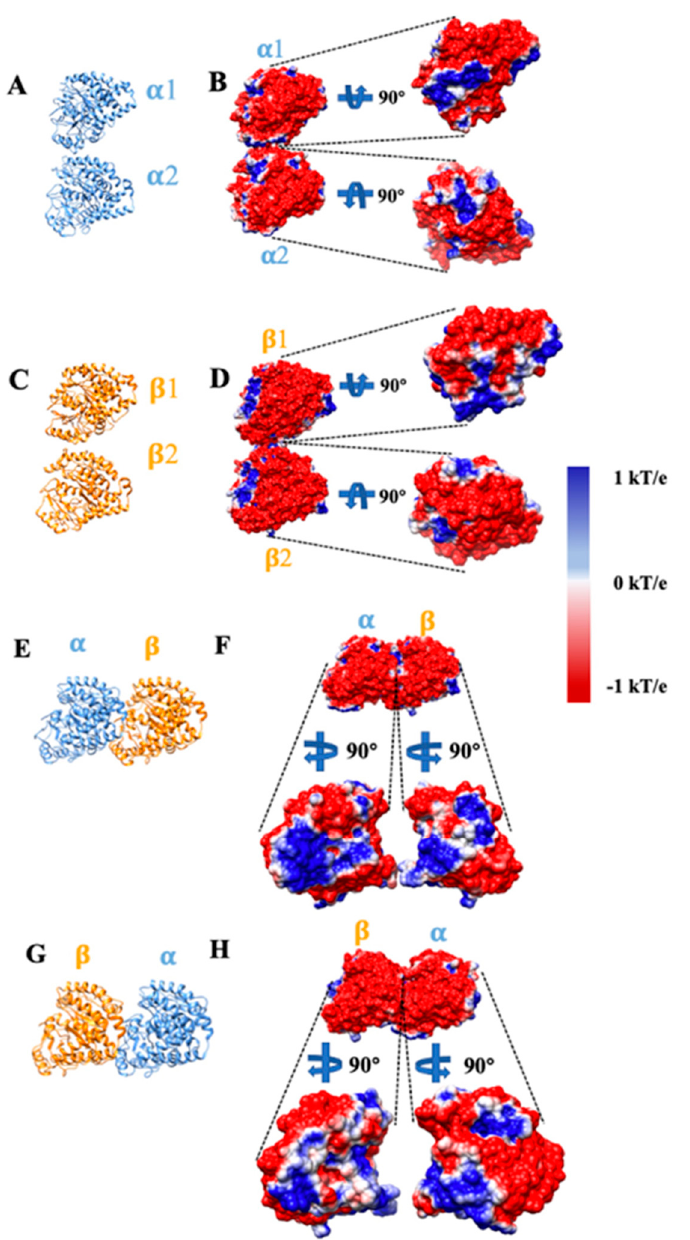
Figure 2. Electrostatic potential at the interfaces of tubulins ( α / α tubulin complex, β / β tubulin complex, α / β tubulin complex, and β / α tubulin complex). ( A , C , E , G ) The ribbon structures of α / α tubulin complex, β / β tubulin complex, α / β tubulin complex, and β / α tubulin complex. All α tubulins are represented in blue, while all β tubulins are represented in orange. ( B , D , F , H ) The electrostatic potential surface of α / α , β / β , α / β , β / α tubulins. Negatively and positively charged regions are red and blue, respectively. In each complex, the monomers are separated by 20 Å and rotated by 90° to show the binding interfaces.